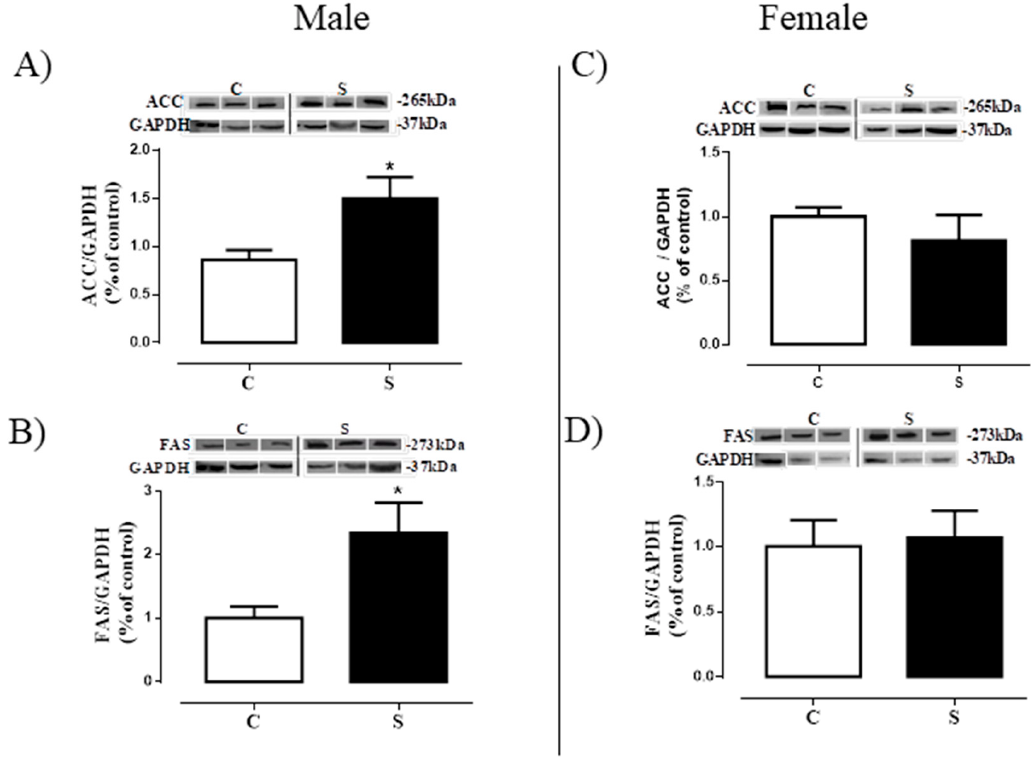
Figure 6. Lipogenesis in visceral adipose tissue of adult rats programmed by smoke exposure during